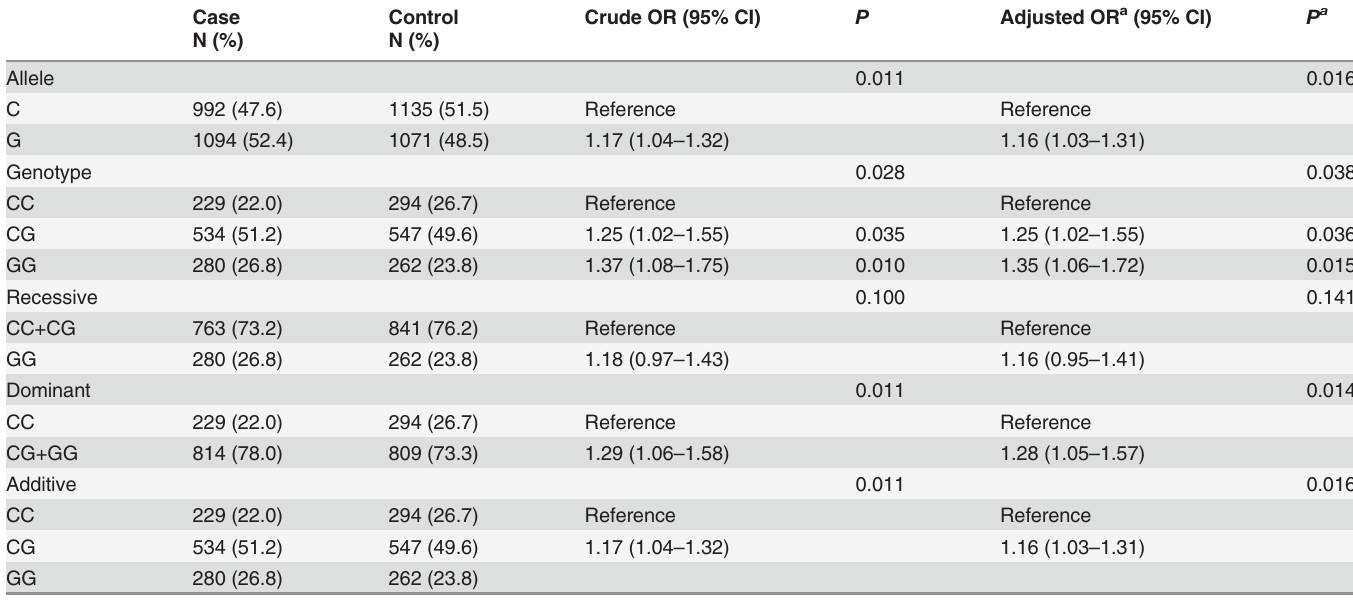
Table 2. Association analyses between ADD1 -rs4963 and CRC